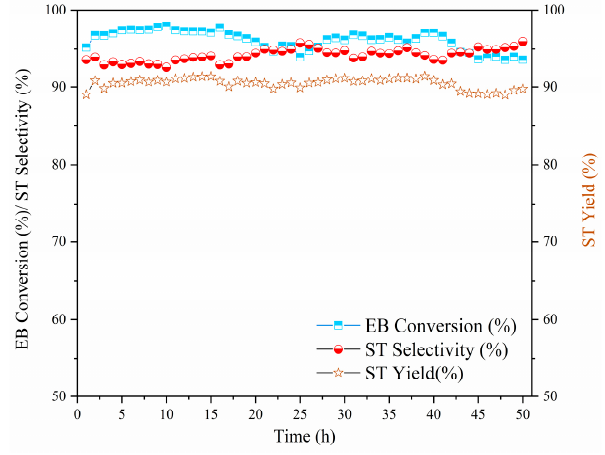
Figure 9. Stability test of 10%K/CeO 2 . Reaction conditions: 500 ◦ C, flow rate 25 mL/min, mixed atmosphere CO 2 -4O 2 , space velocity 5.0 h − 1 .